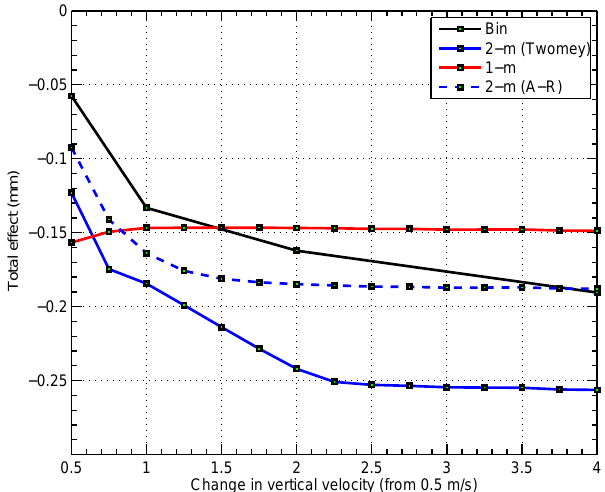
Fig. 12. Total effect on suppression of precipitation (in mm) from each scheme as a function of changes in w 1 and CCN, under a fixed temperature ( T =RICO). Changes in w 1 are considered from 0.5ms − 1 up to 4ms − 1 , and the change in CCN is from 50/cc to 100/cc.